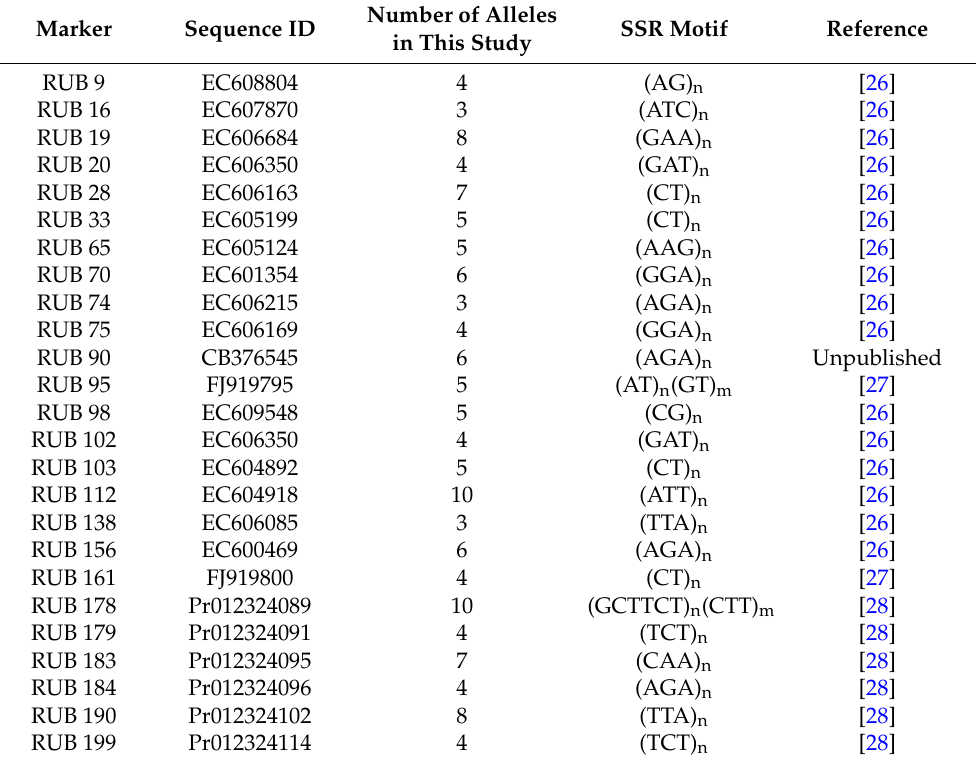
Table 2. Characteristics of screened 25 SSR markers in Hevea brasiliensis